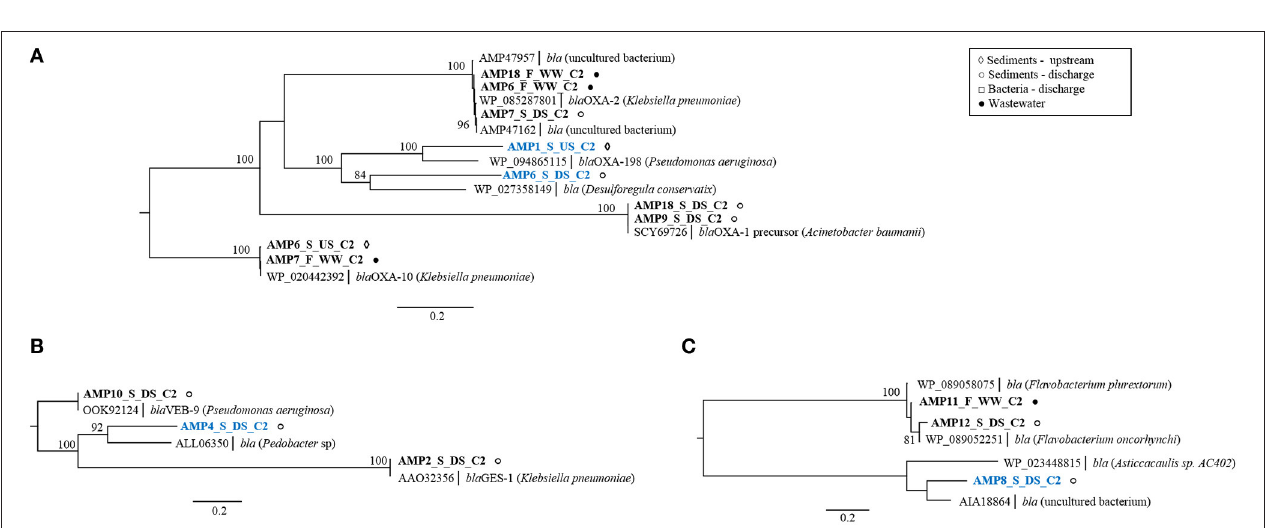
FIGURE 3 | Phylogenetic trees of protein sequences of class D beta-lactamases (A) , class A beta-lactamases (B) , and class B beta-lactamases (C) . Best BLAST hits and representative protein sequences of the studied gene were retrieved from the NCBI database. The evolutionary history was inferred by using the maximum likelihood method and the Geneious software. Bootstrap values were calculated on 100 replications and only those higher than 80% are shown. Sequences that share ≤ 80% amino acid identity with proteins in NCBI database are shown in blue. Scale bar = 0.2